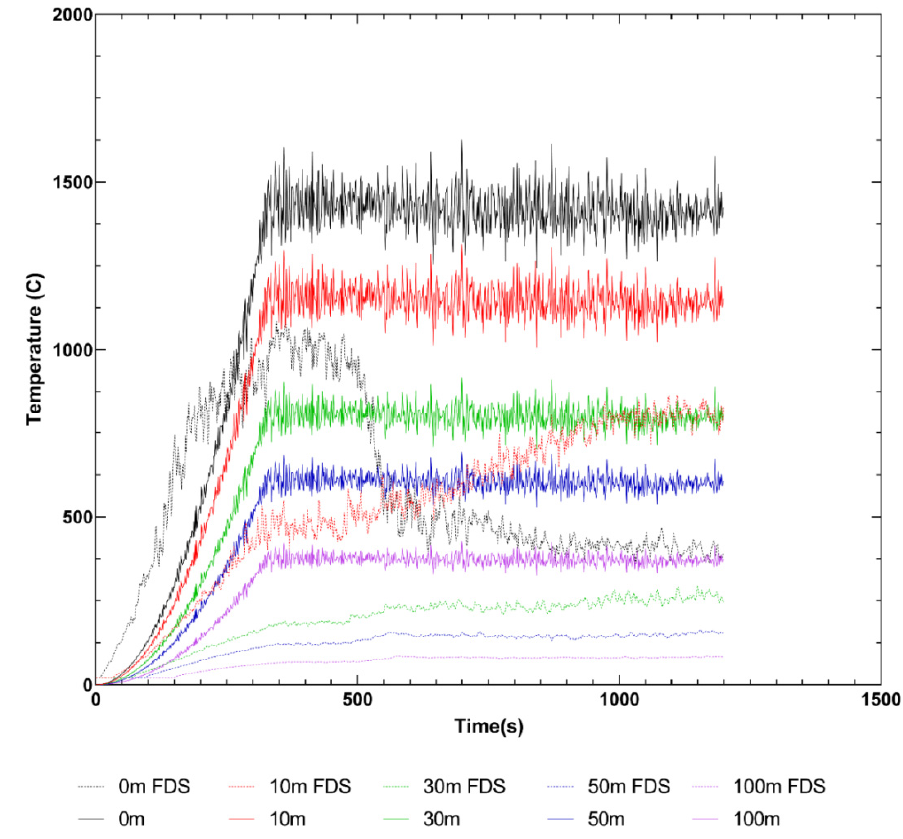
Figure 4. Temperatures at the tunnel ceiling (z = 7 m) above (x = 0 m) and downwind the fire source (x = 10, 30, 50 and 100 m) for Scenario C, calculated using the empirical model and the actual temperatures from the FDS output.